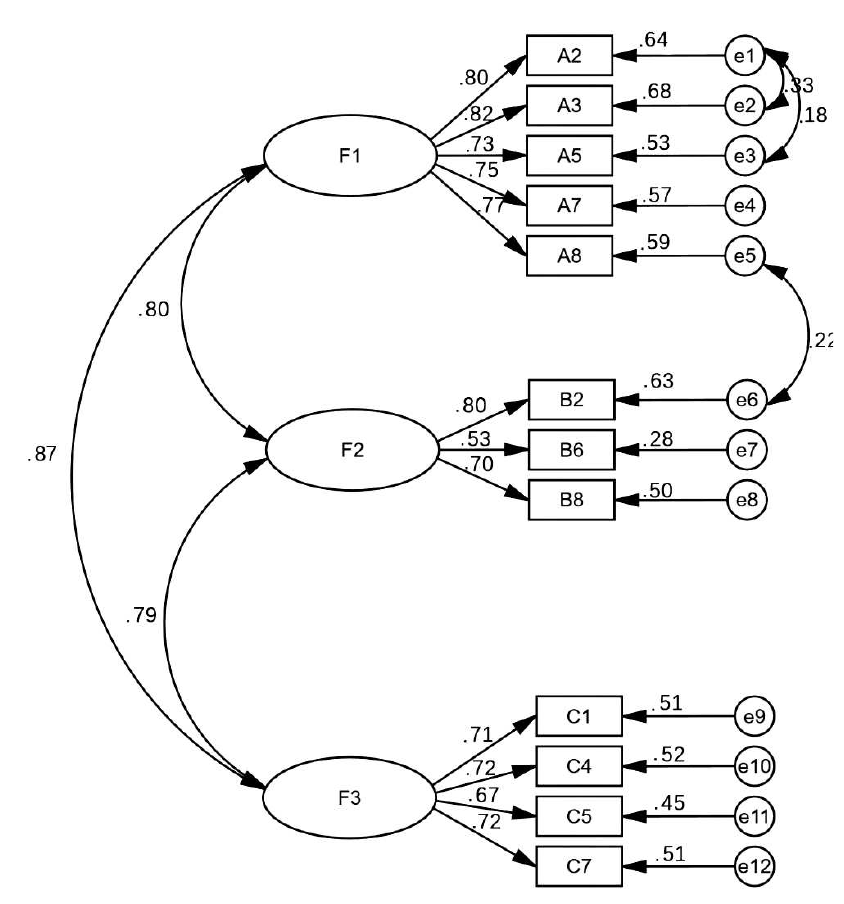
Figure 1. Confirmatory factors